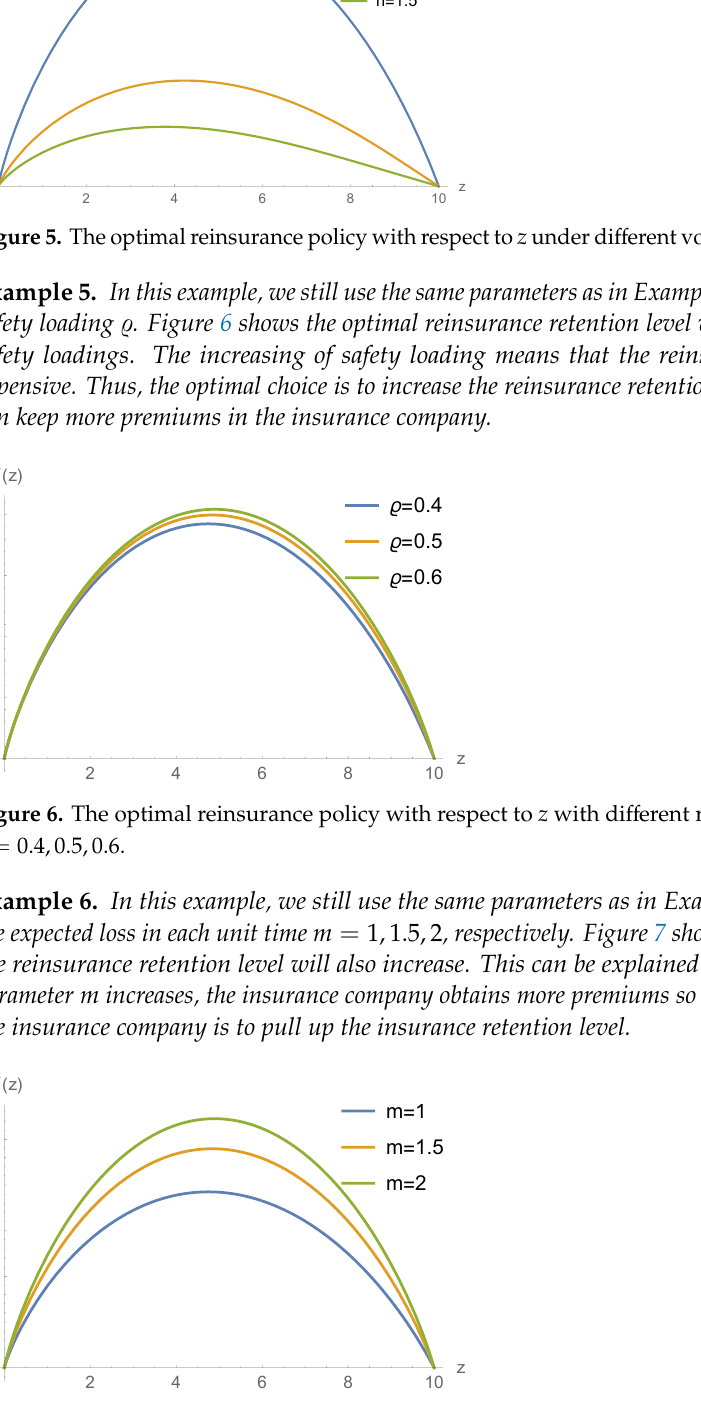
Figure 7. The optimal reinsurance policy under di ff erent expected losses in unit time m =